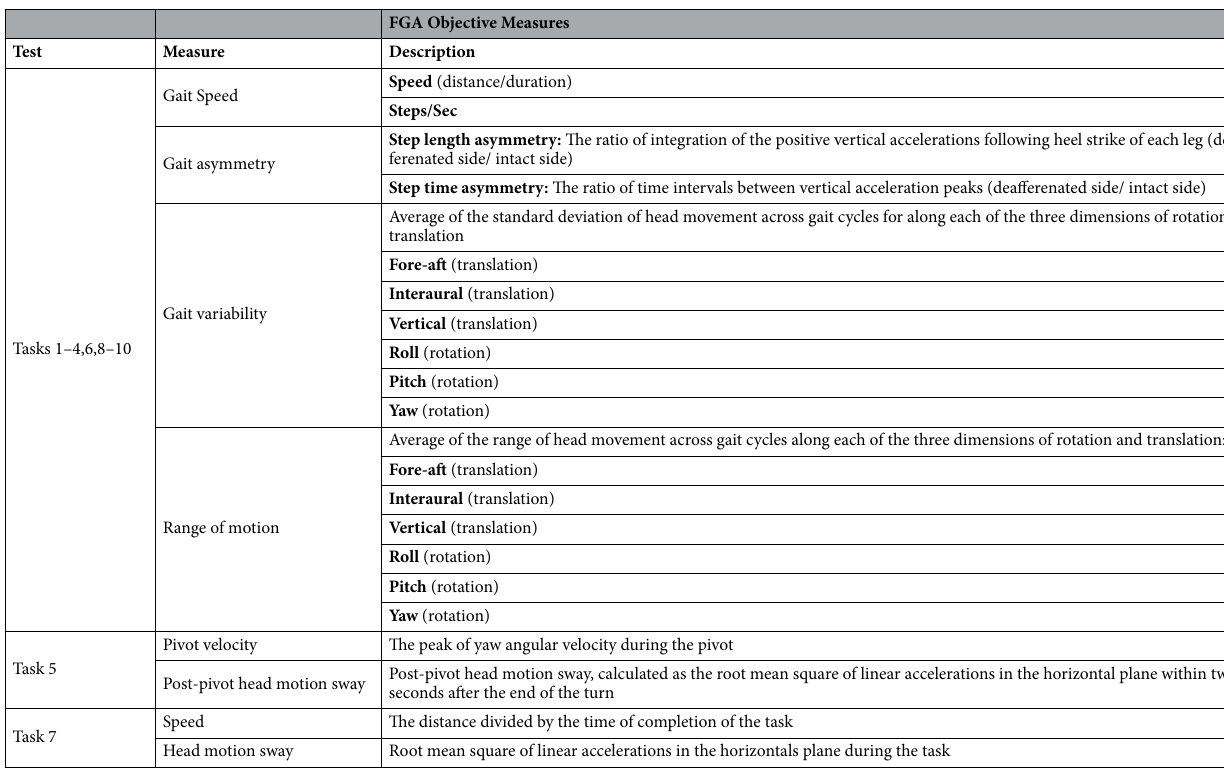
Table 1. List of the kinematic measures used in this